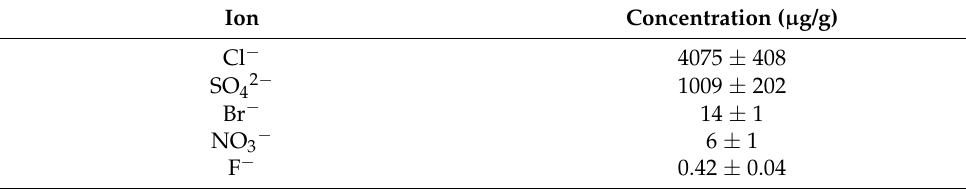
Table 1. Main ions present in the sediment sample determined by ionic chromatography.